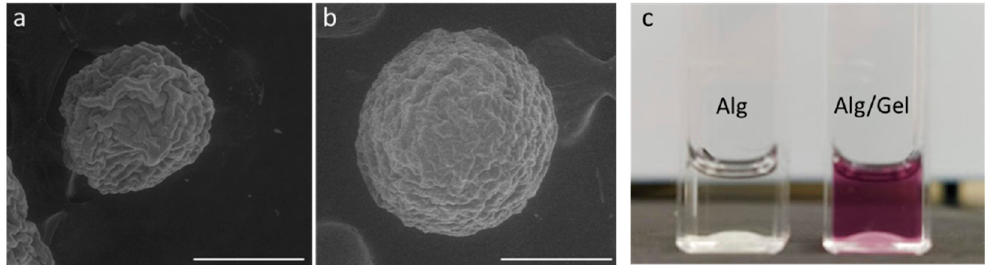
Figure 3. SEM images of ( a ) Alg and ( b ) Alg/Gel microgels (scale bar: 300 µm). ( c ) Ninhydrin stain- ing test to detect the presence of gelatin into the bicomponent microgels. staining test to detect the presence of gelatin into the bicomponent